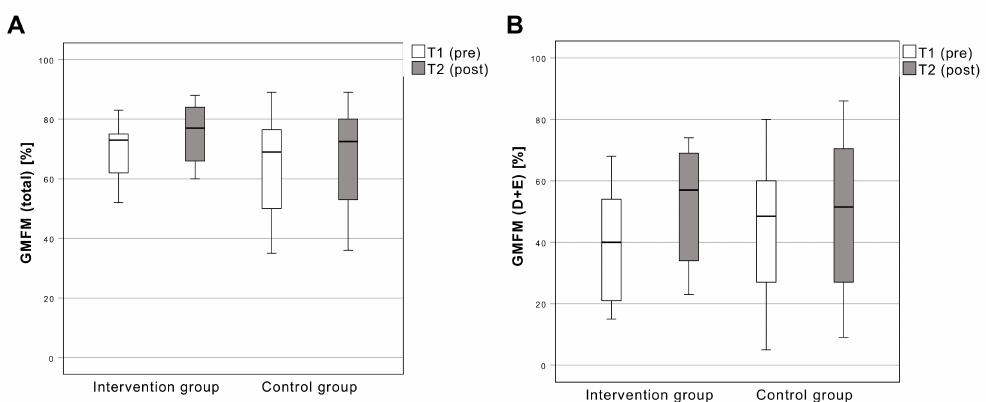
Figure 5. Results of the Gross Motor Functions Measure total ( A ) and Dimension D + E ( B ). Boxplots: Middle line: median; lower whisker: minimum value; upper whisker: maximum value; circles: Outliers (1.5 times interquartile range); p < 0.05; T1: measurement pre-intervention; T2: measurement post-intervention; Confidence interval: 95%; n = 25.